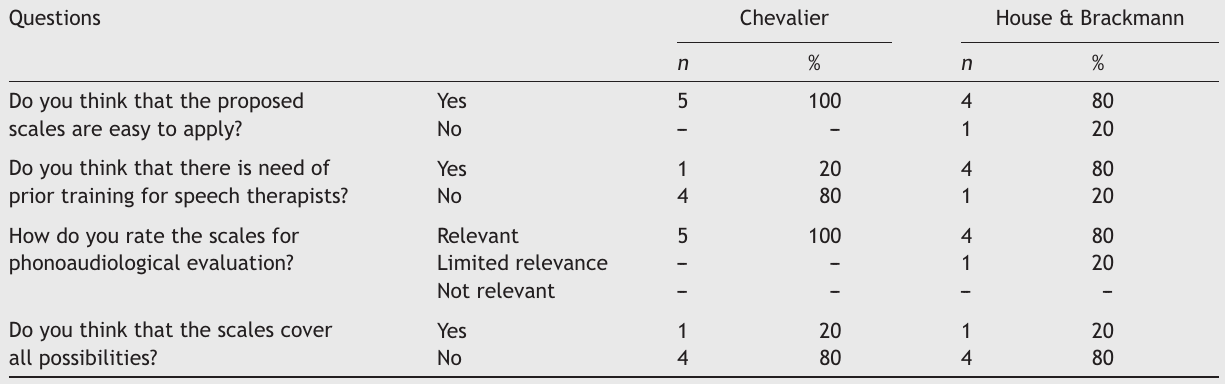
Description of the appraisers’ point of view regarding the scales of facial